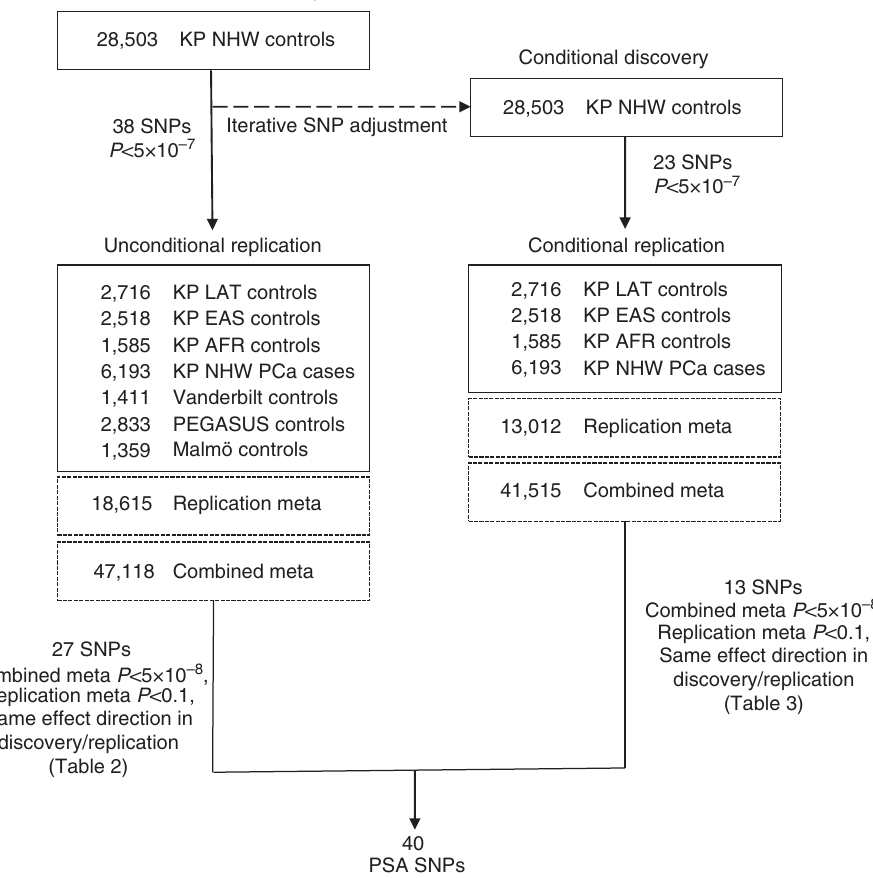
Figure 1 | Flow chart highlighting the approach and samples used to detect SNPs associated with PSA from GWAS. First we undertook an unconditional discovery GWAS in the KP non-Hispanic white non-cases. Thirty-eight SNPs associated with PSA ( P o 5 (cid:2) 10 (cid:3) 7 ) were then included as covariates in a second conditional discovery GWAS. All SNPs associated with PSA ( P o 5 (cid:2) 10 (cid:3) 7 ) from these two GWAS (38 þ 23) were evaluated for replication in two steps, first in an analysis of the replication cohorts alone, and then in a meta-analysis combining the discovery and replication cohorts. A total of 40 independent SNPs (27 in unconditional GWAS, 13 in conditional GWAS) met criteria of combined meta P o 5 (cid:2) 10 (cid:3) 8 , replication meta P o 0.1, and same effect direction in